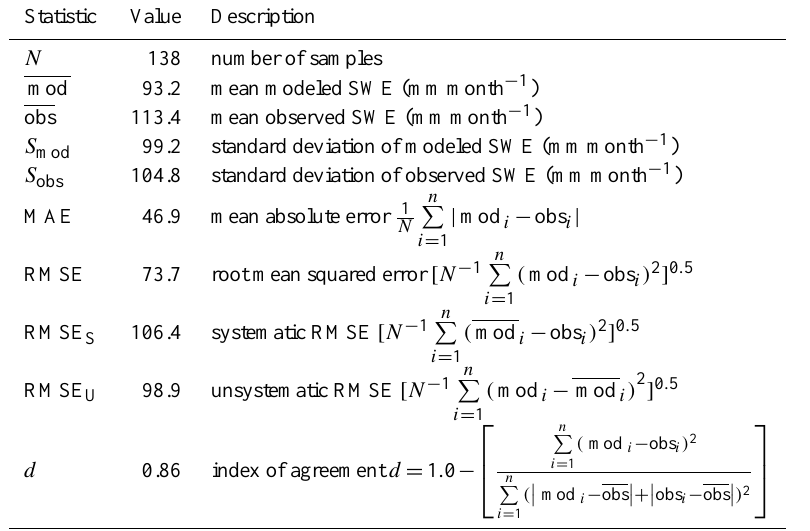
Table 3. Various statistical metrics describing the strength of the relationship between observed and modeled SWE at one location (centered at 38.92 ◦ N and 40.25 ◦ E). The description and the formulas used to derive the metrics are also provided.